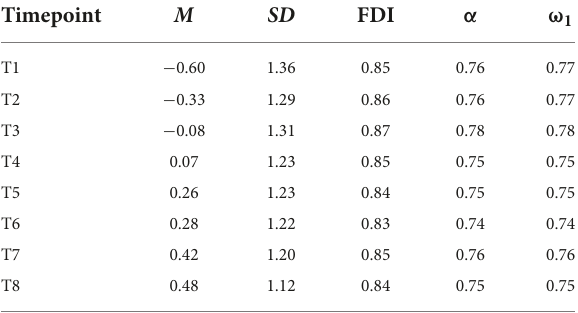
TABLE 1 Descriptive statistics and reliability estimates for reading achievement at each measurement